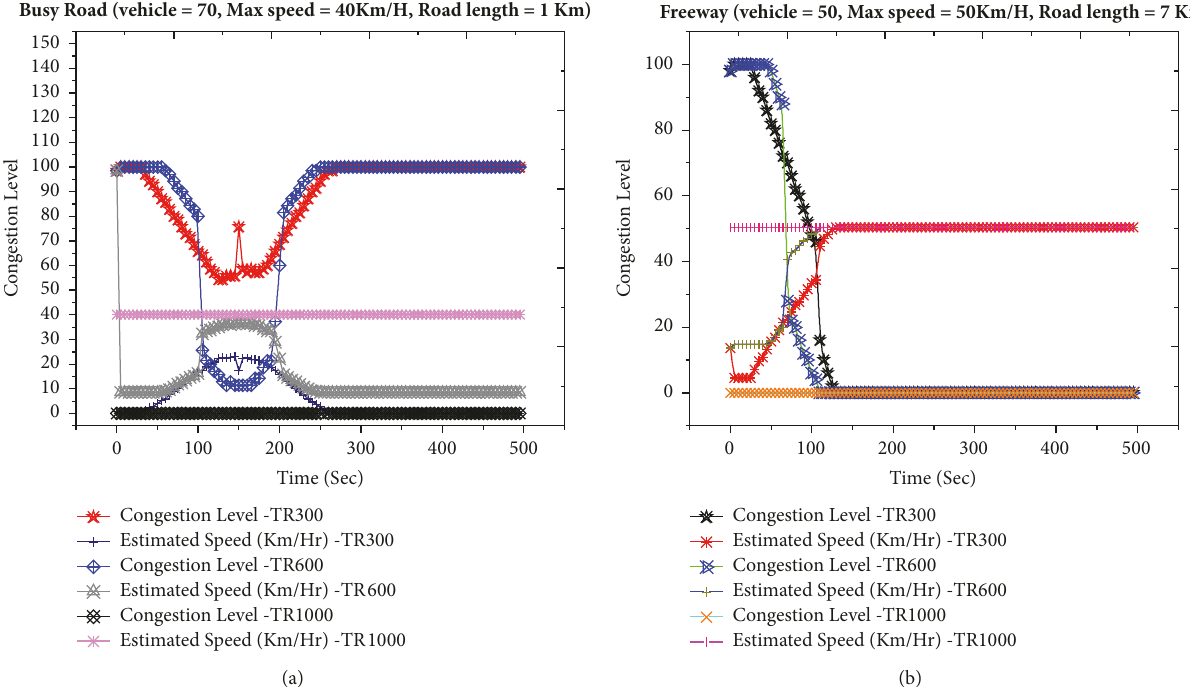
Figure 7: Temporal congestion detection and speed estimation using different transmission ranges, number of lanes = 2, car size = 5m, safety time threshold = 2 sec, and simulation time = 500 seconds.